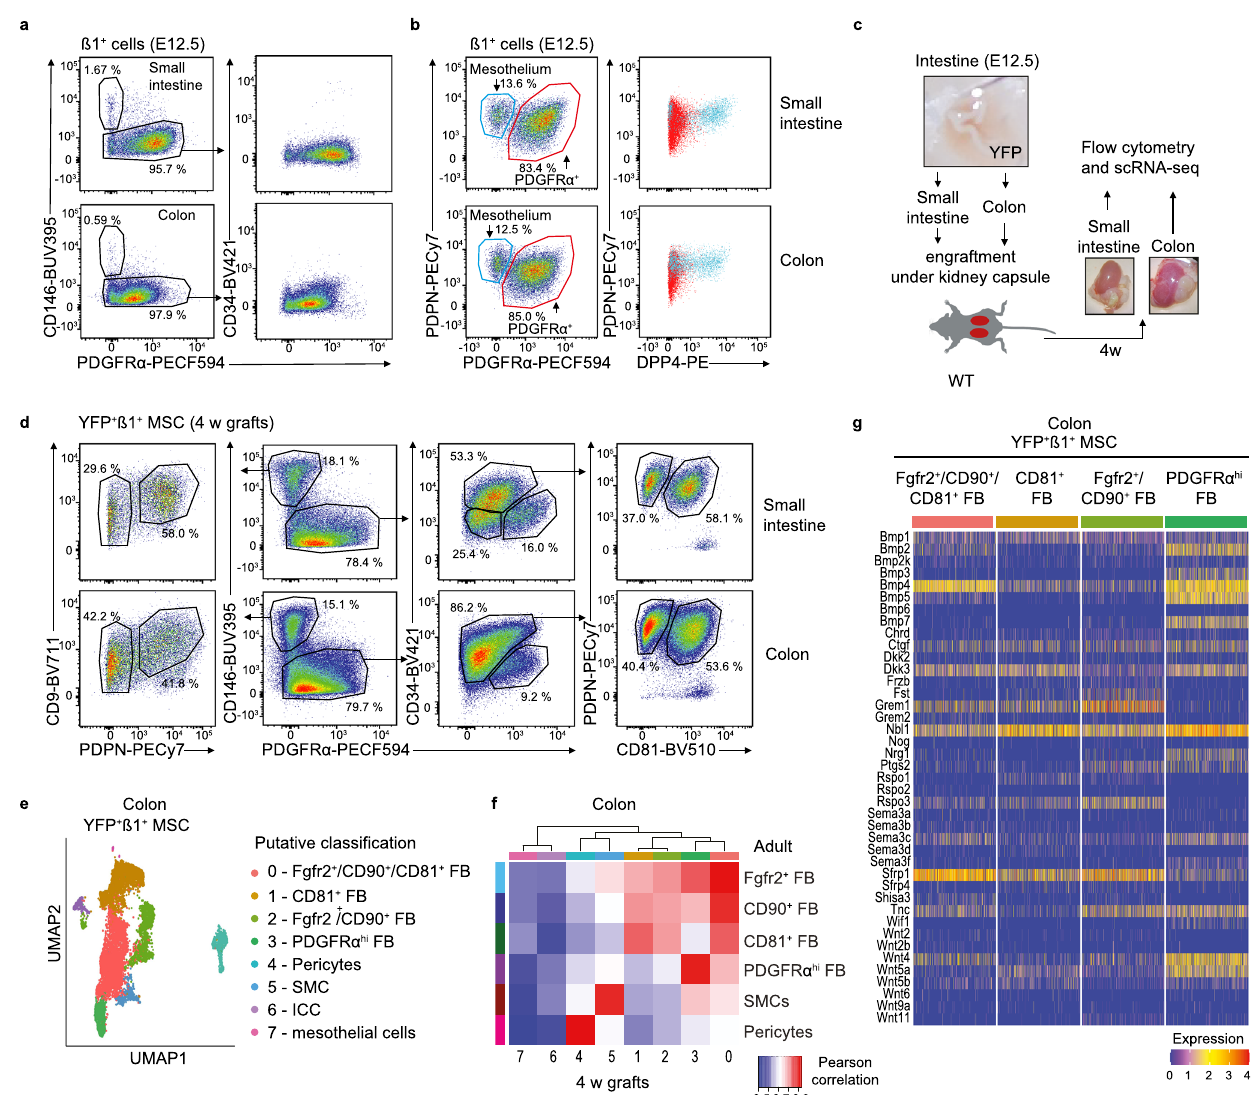
Fig. 3 | Adult intestinal MSC subsets derive from intestinal precursors present in E12.5 intestine. a , b Flow cytometric analysis of Itg β 1 + MSCs isolated from indicatedorgans onembryonicday(E) 12.5. b Right hand plots show expression of DPP4 (CD26) on gated PDPN + PDGFR α − (blue) and PDPN + PDGFR α + (red) cells